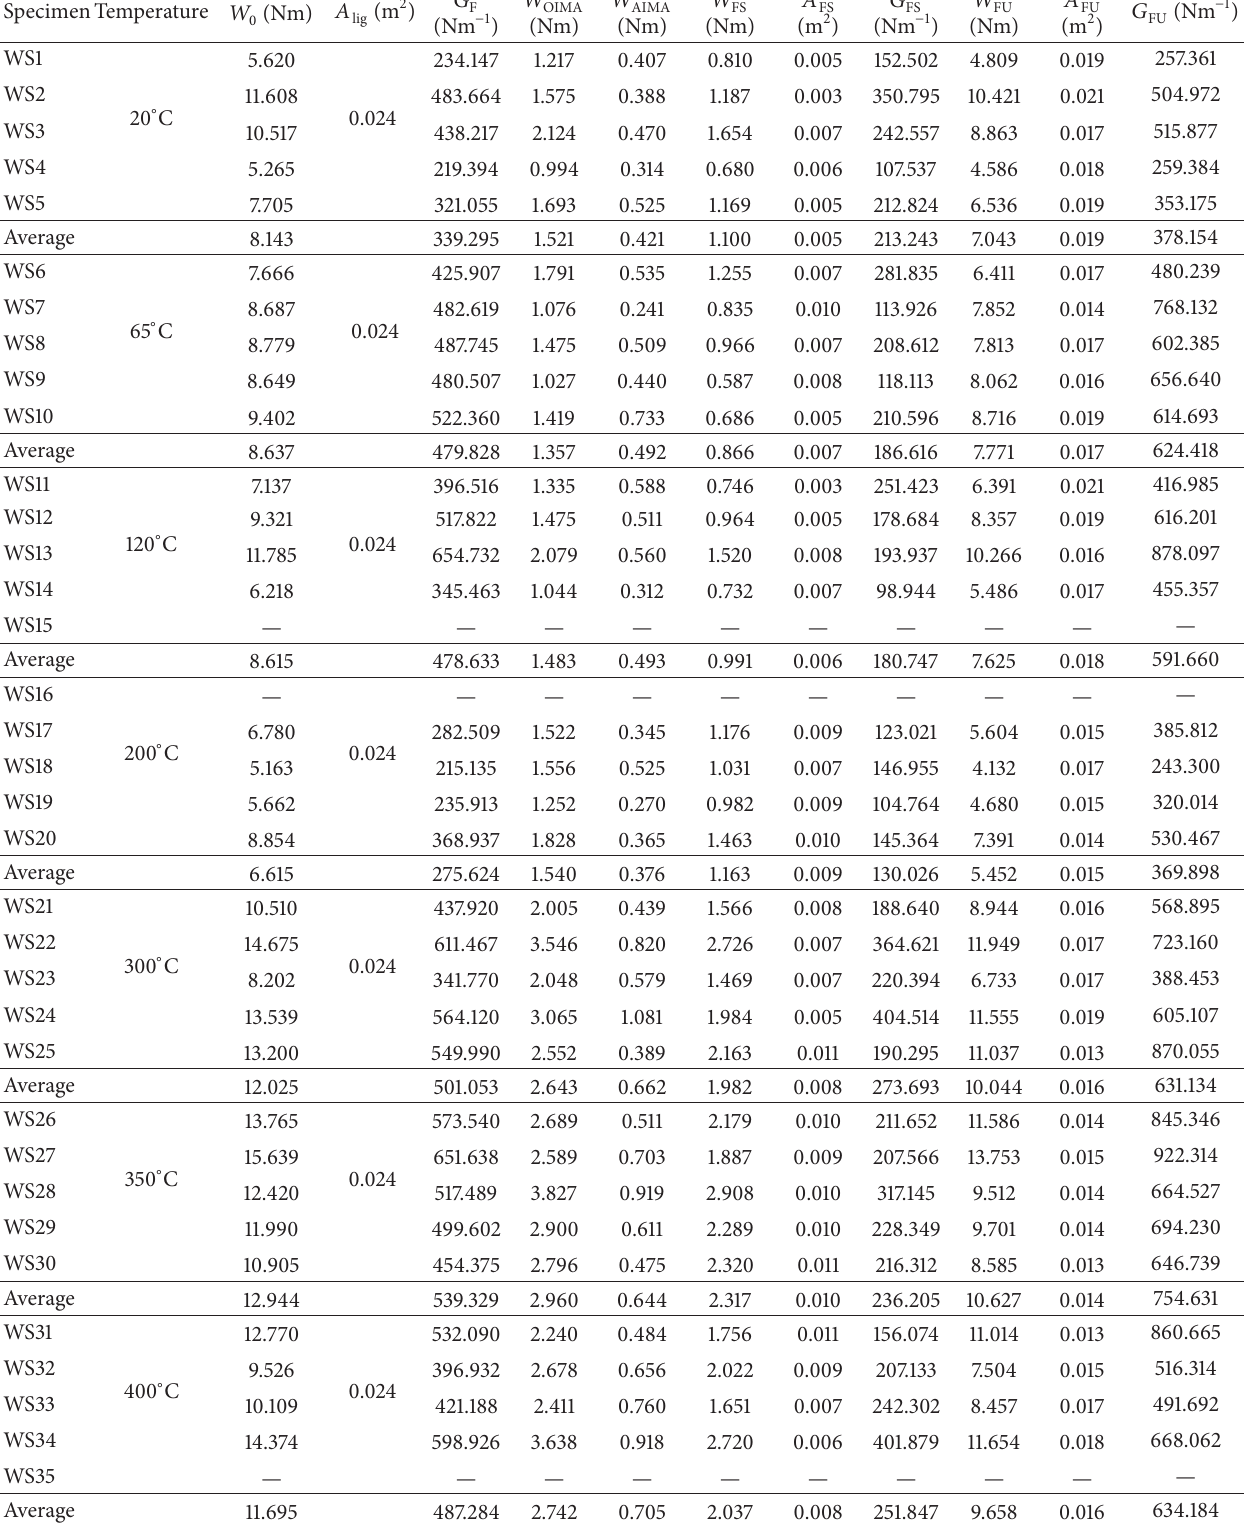
Table 2: Fracture energies for crack